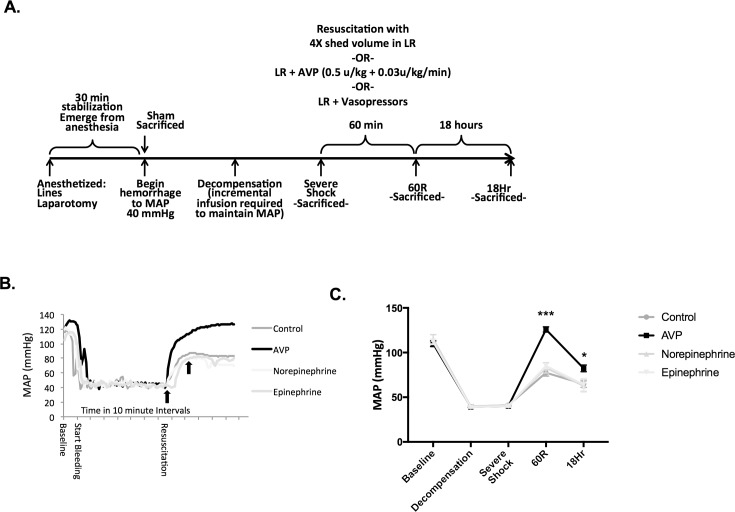
Resuscitation with AVP restores the mean arterial blood pressure.(A) Male Long Evans rats were anesthetized with isoflurane (4%) followed by vascular line placement and laparotomy to simulate soft tissue injury. After complete emergence from anesthesia, awake animals were passively bled to a mean arterial pressure (MAP) of 40 ± 5 mmHg. When animals could no longer maintain a MAP of 40 mmHg without fluid (Decompensation), they were given incremental 0.2 cc boluses of lactated Ringer’s (LR) until 40% of the shed volume was returned (Severe Shock). Animals were resuscitated over 60 minutes with 4X the shed volume in LR and either arginine vasopressin (AVP: 0.5 U/kg + 0.03 U/kg/hr) or placebo. Animals were sacrificed at Baseline (Sham n = 9/group), Decompensation (n = 9/group), Severe Shock (n = 9/group), following resuscitation (60R, n = 9/group) and 18 hours post resuscitation (n = 6/group). An additional group of animals were treated with increasing doses of norepinephrine (3 and then 6 ug/kg/min) or epinephrine (1.2 and then 2.4 ug/kg/min). (B) Blood pressure tracings of a representative animal from each group are depicted. Black arrows depict the time vasopressors were initiated, and then increased. (C) The mean arterial blood pressure (MAP) at each time point was recorded. Data were analyzed using one-way ANOVA with a post hoc Tukey’s test. Values are means ± SEM. AVP treated vs. other treatment groups; * p<0.05, ***p<0.001.